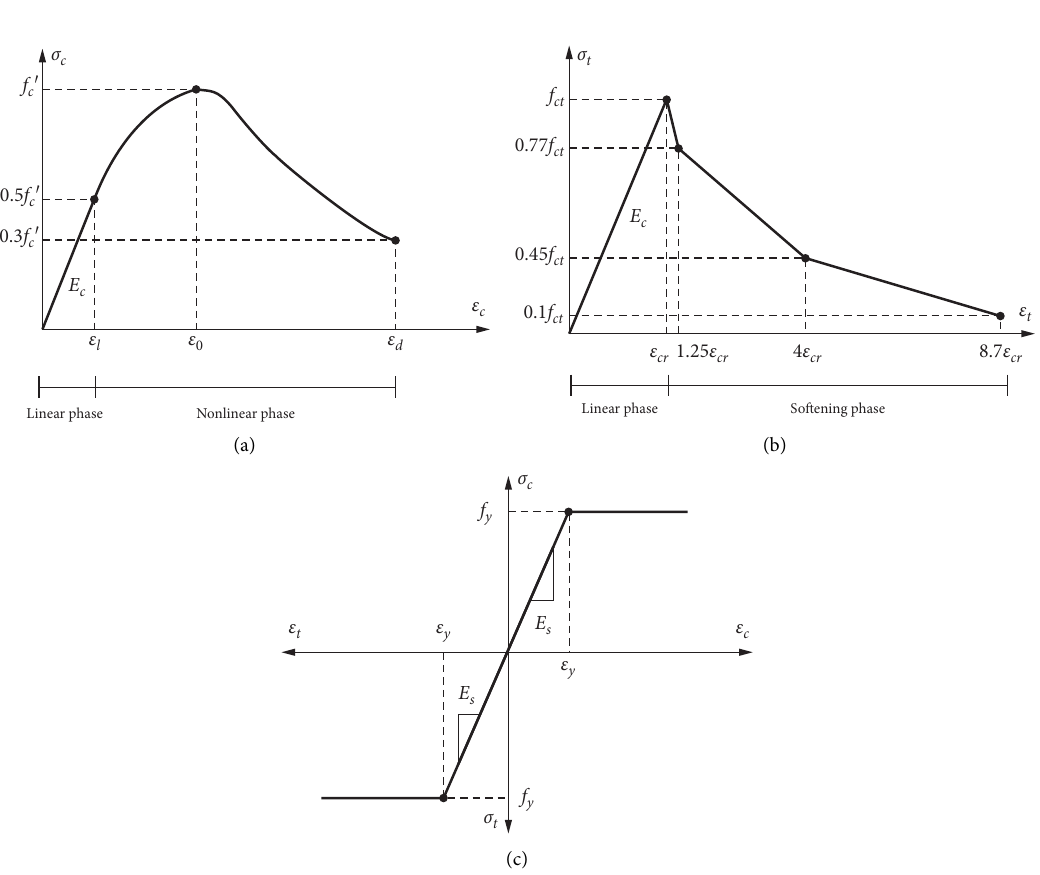
Figure 3: Materials stress-strain relationship: (a) uniaxial compression of concrete, (b) uniaxial tension of concrete, and (c) bilinear curve of